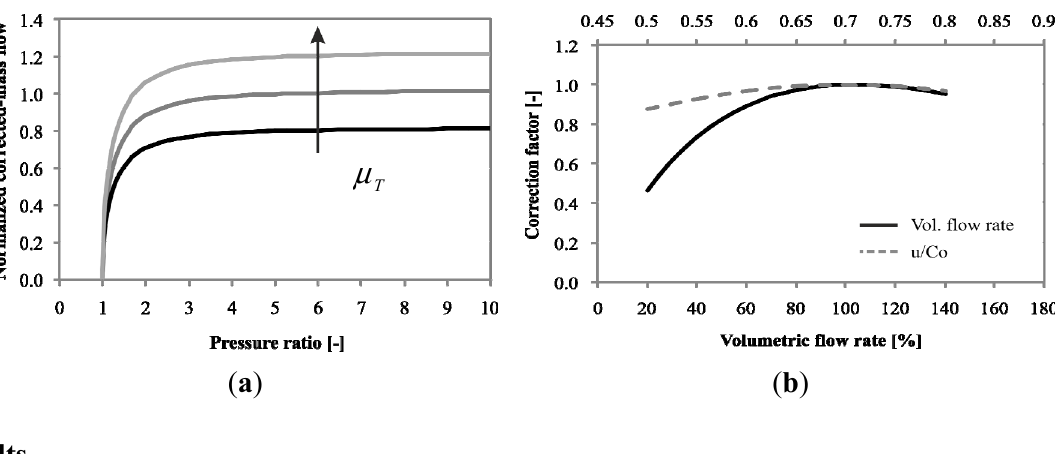
Figure 5. ( a ) Stodola’s cone rule as a function of nozzle position; ( b ) Typical turbine efficiency characteristics